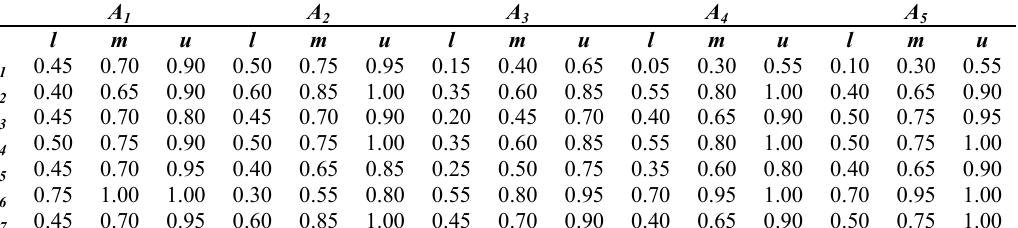
Table 5. Fuzzy decision matrix of the